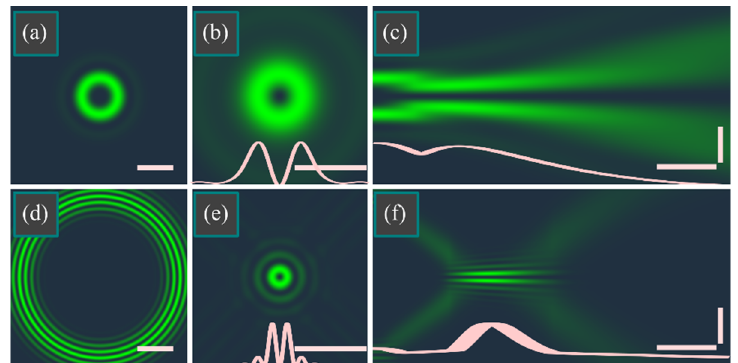
Figure 4. Transverse initial ( a , d ) and focal ( b , e ) intensity distributions, as well as the longitudinal intensity distributions ( c , e ) of the beam from Equation (1) with the ( n , m ) = (1, 2) ( a – c ) and with the ( n , m ) = (20, 21) ( d , f ). Curves ( b , c , e , f ) show the intensity cross ‐ sections. Horizontal scale marks in the transverse patterns denote 1 mm. Horizontal and vertical scale marks in longitudinal patterns denote z 0 /2 and 1 mm, respectively.